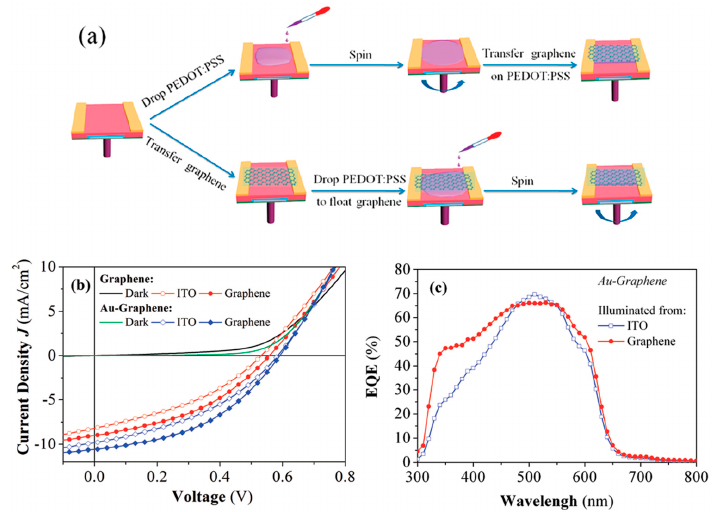
Figure 13. ( a ) Diagrammatic representation of the two methods for producing graphene/PEDOT: PSS top electrodes in organic solar cells. ( b ) Under a solar simulator, J-V characteristics of semitrans- parent organic solar cells with a pure or Au-dopped graphene top electrode were measured on both sides. The devices’ dark currents are also shown. ( c ) Organic solar cell with Au-doped graphene/PE- DOT:PSS top electrode. EQE was measured from both sides. The results from the ITO and graphene sides are represented by the open and solid symbols, respectively [138]. In producing solar devices with graphene with multilayer stacking, the most suitable method is Chemical vapour deposition (CVD). During the lamination process, a fine layer of PEDOT:PSS was used as an adhesion layer to perovskite film, which also enhanced the conductivity of graphene. When illuminated from the FTO and Graphene sides, the de- vices showed approximately 12.02% and 11.62% PCE, respectively. Tran et al. recently published a flexible monolayer graphene in a large-scale and translucent bottom elec- trode. Plasma-assisted thermal chemical vapour deposition on a polymer substrate was used to directly synthesise graphene at 150 degrees Celsius without the usage of a transfer method. The top electrode was AZO/Ag/AZO, and the thickness of the cell around 300